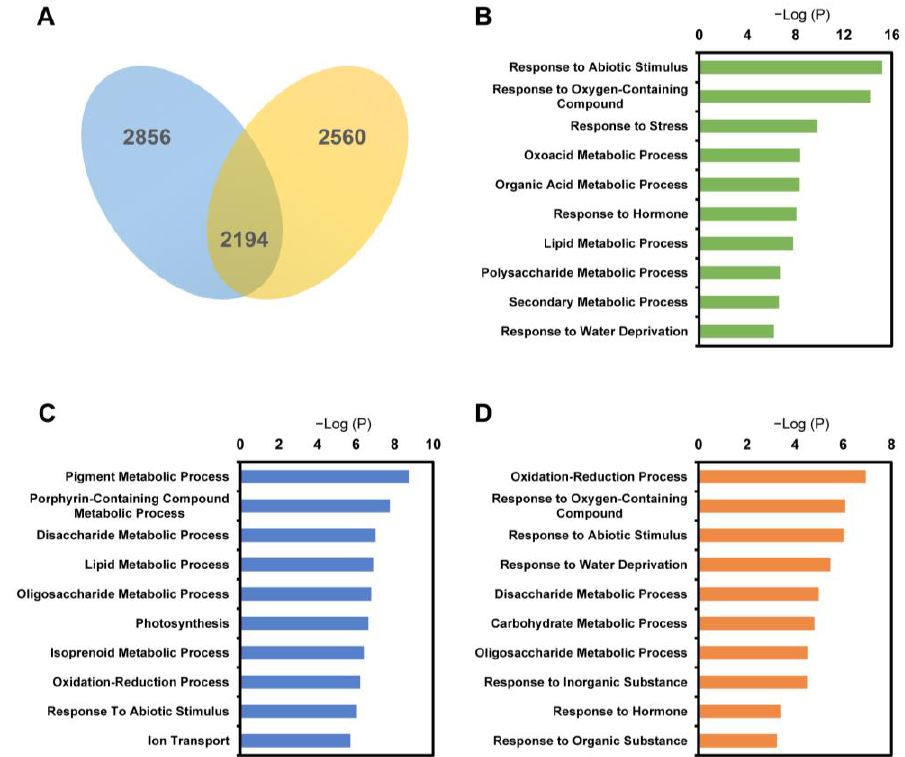
Figure 4. Gene number and significantly enriched GO terms of expression pattern cluster gene sets. Expression pattern cluster analysis divided DEGs into three gene sets: common response DEGs, RIO-specific response DEGs and SN005-specific response DEGs. ( A ) Venn diagram showing the gene number for three gene sets. ( B ) Top 10 significantly enriched GO terms for common response DEGs, ( C ) RIO-specific response DEGs, and ( D ) SN005-specific response DEGs. The GO terms with p < 0.01 were considered significantly enriched.